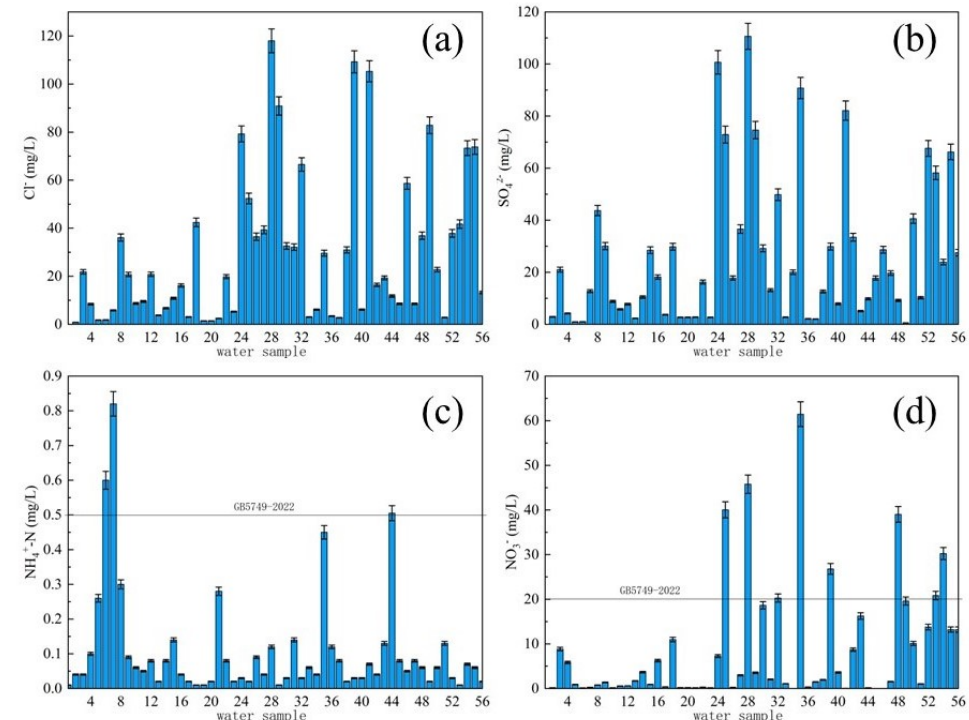
Figure 9. Inorganic ion concentration distribution of drinking water sources in typical villages and towns of M area: ( a ) l − , ( b ) SO 42 − , ( c ) NH 4+ -N, ( d ) NO 3 − -N.